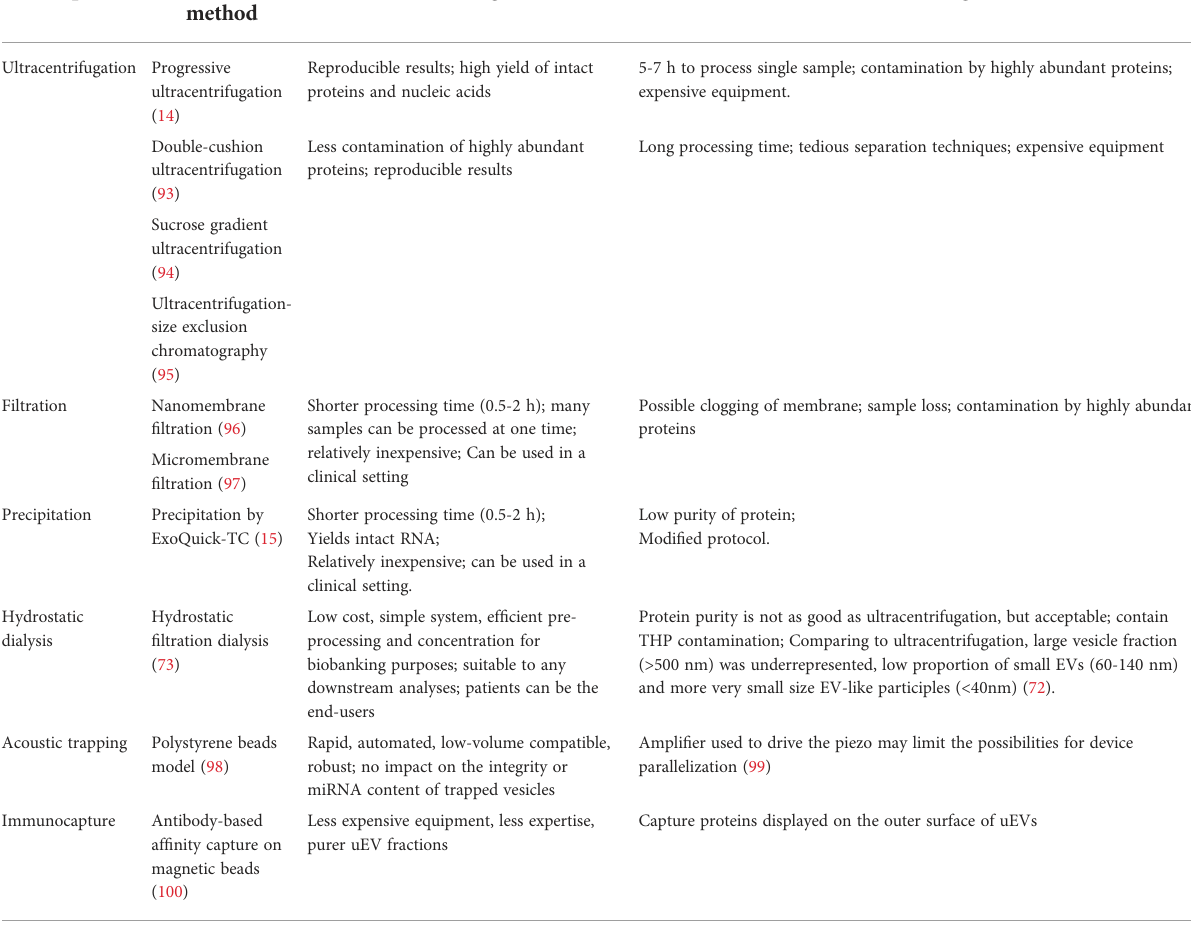
TABLE 2 Methodologies used for uEV